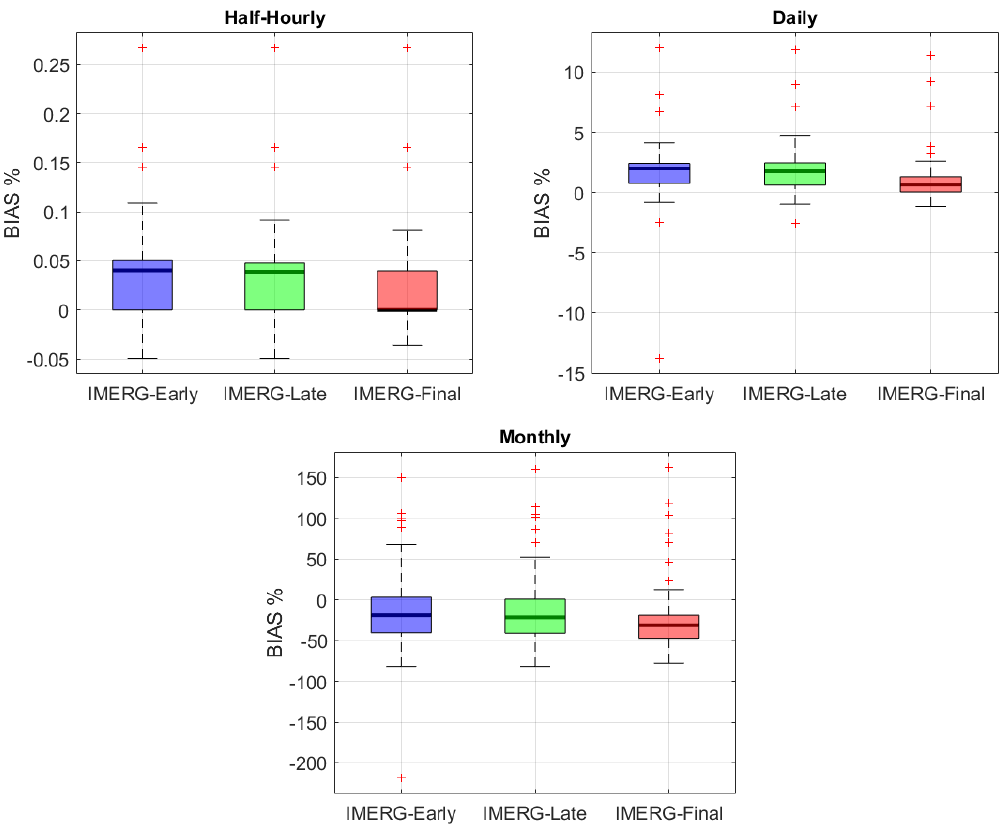
Figure 16. Half-hourly, daily, and monthly BIAS for IMERG-Early, IMERG-Late, and IMERG-Final.